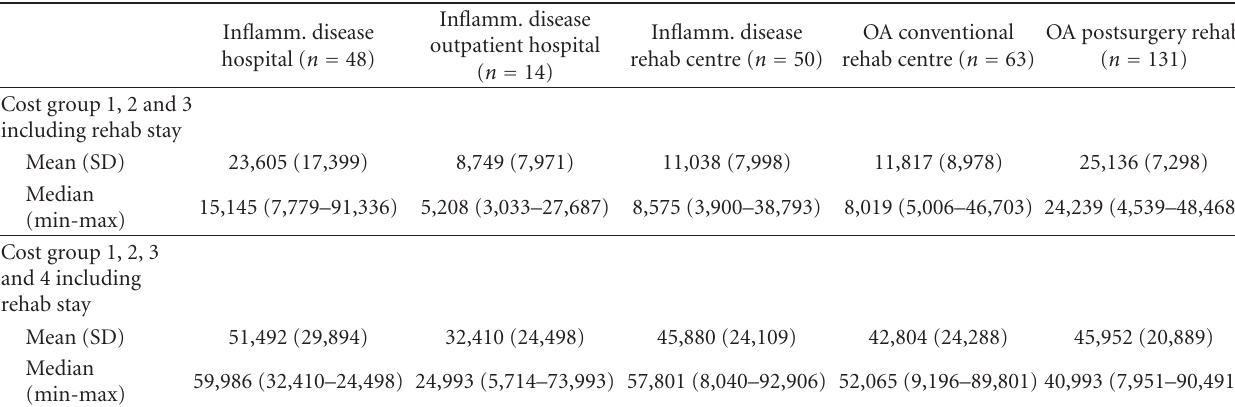
Table 4: Mean (SD) and median (min-max) health care costs (summary of 1, 2, and 3) and health care- and social costs (summary of 1, 2, 3, and 4) for the whole observation period. Costs are in Euro